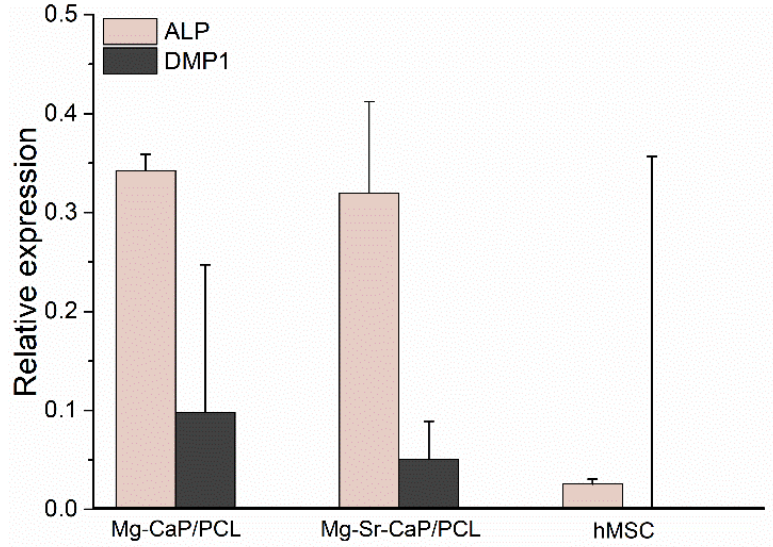
Figure 9. Relative expression of osteogenic markers on 1-Mg-CaP/PCL and 1-Mg-1-Sr-CaP/PCL scaffolds after 21 days of osteogenic induction. The relative gene expression was analyzed by the comparative cycle threshold method ( ∆∆ Ct) and the values were normalized to β -actin expression. Quantified osteogenic markers were alkaline phosphatase (ALP) and dentin matrix protein 1 (DMP1). Undifferentiated hMSCs were used as a negative control, while human bone was used as a positive control (relative expression = 1).